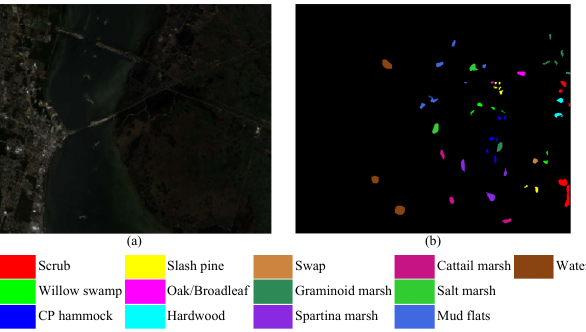
Figure 6. ( a ) False-color image and ( b ) ground truth for the UP data set.